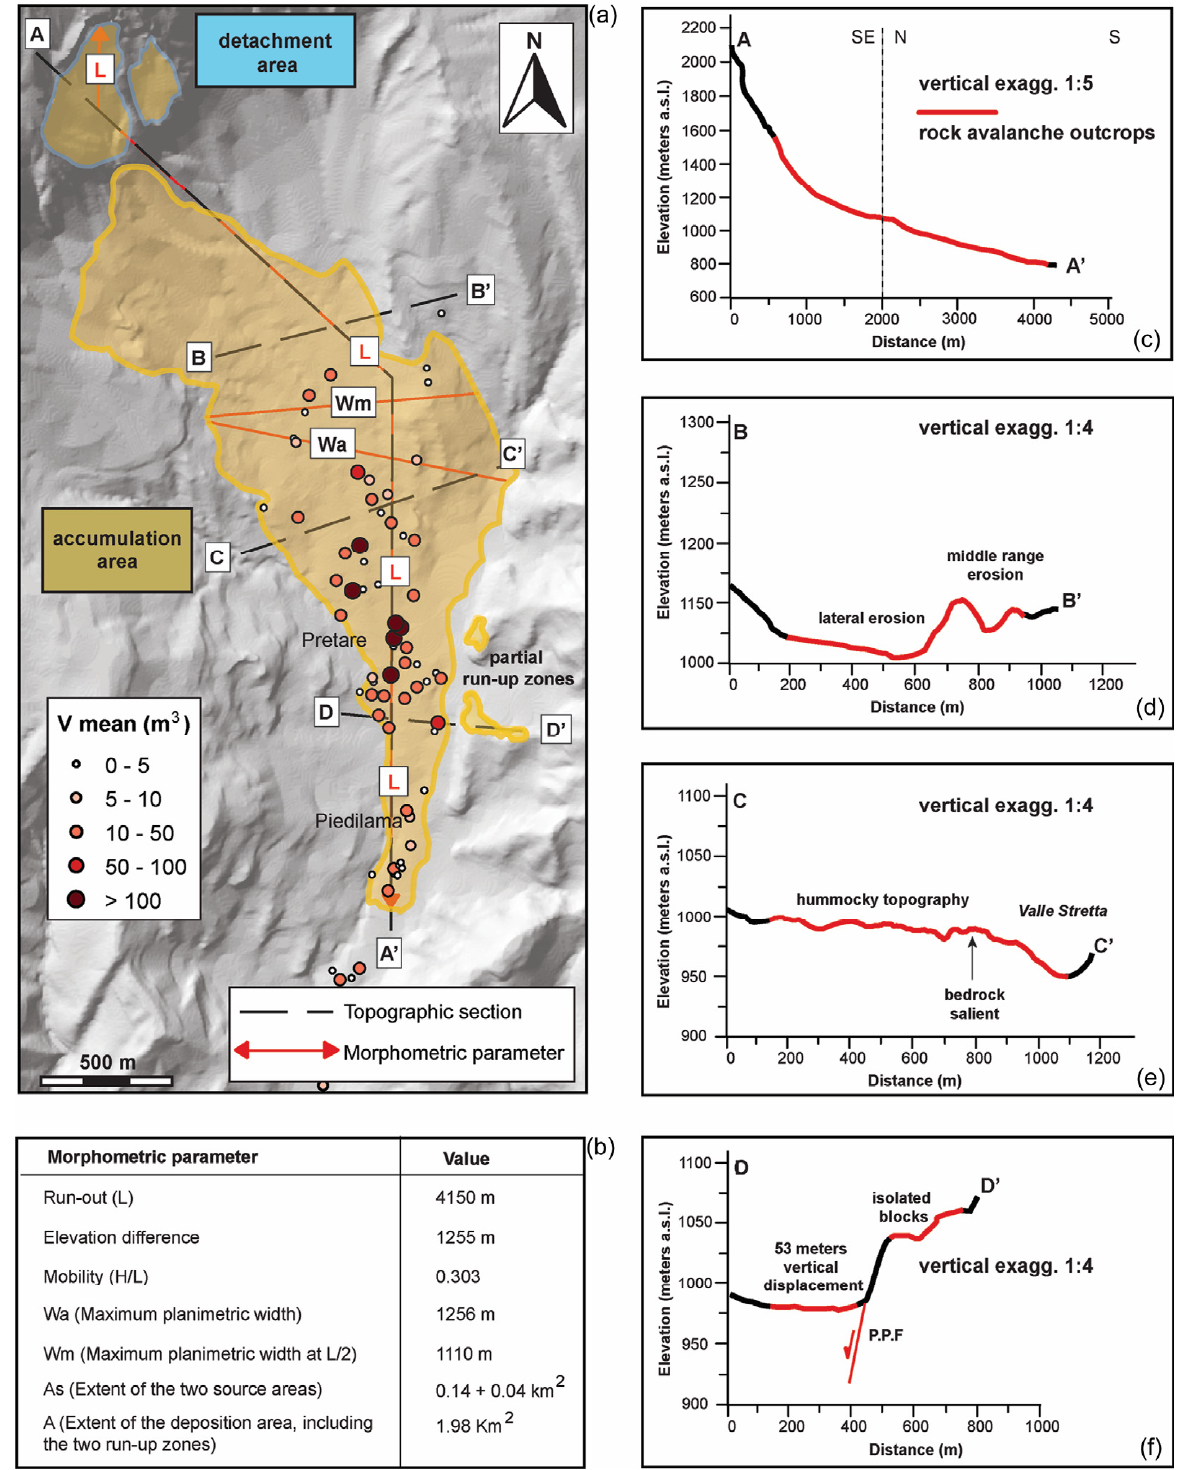
Figure 14. ( a ) Accumulation area of the Pretare ‐ Piedilama rock avalanche (V mean distribution is also reported); ( b ) main morphometric parameters; ( c – f ) topographic cross sections. Legend: P.P.F. = Pretare ‐ Piedilama Fault.